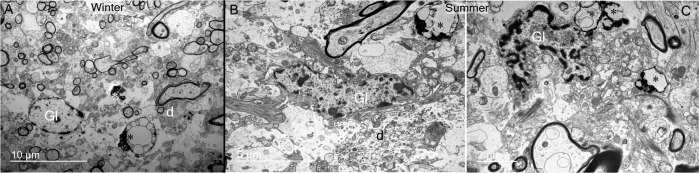
Debris material in supraoptic nucleus dendritic zone observed in summer and winter seasons.(A) Degenerative elements (asterisks) are observed near magnocellular neurone spines and dendrites in both seasons. (B, C) These elements (asterisks) are generally abutted by glial processes (Gl) and engulfed (C). It seems that glial cells (Gl) are attracted to debris zones, and possibly remove them from the neuropil by phagocytosis. Note in B and C that glial cells are engulfing debris (asterisks).